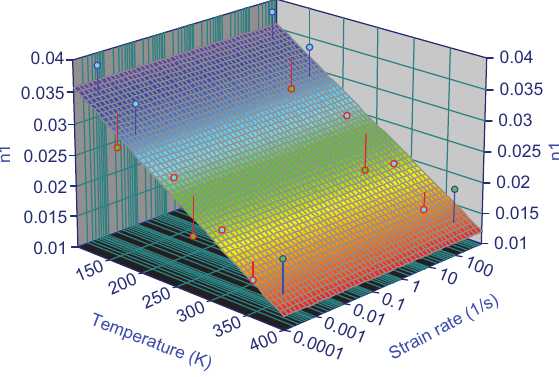
Figure 3 Change of hardening coeffi cient B strain rate.